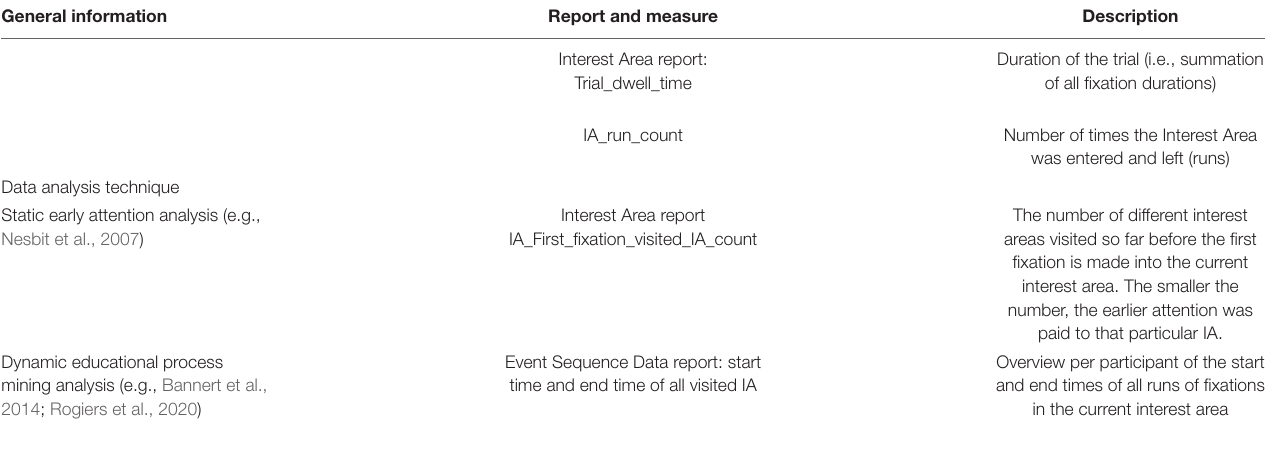
TABLE 1 | Extracted eye tracking variables in Data